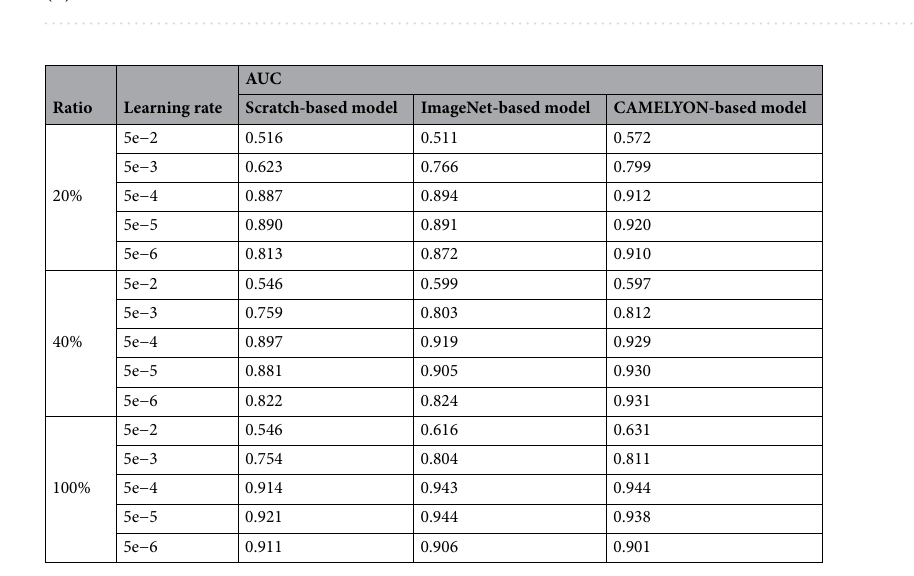
Figure 3. An example of Grad-CAMs for tumor patch with scratch-, ImageNet-, and CAMELYON16-based models trained with different dataset ratios. Confidence below each result indicates the value of the last fully connected layer in each model. ( a ) Input patch, Grad-CAM results of models trained with ( b ) 4%, ( c ) 20%, and ( d ) 100% of the total AMC dataset.